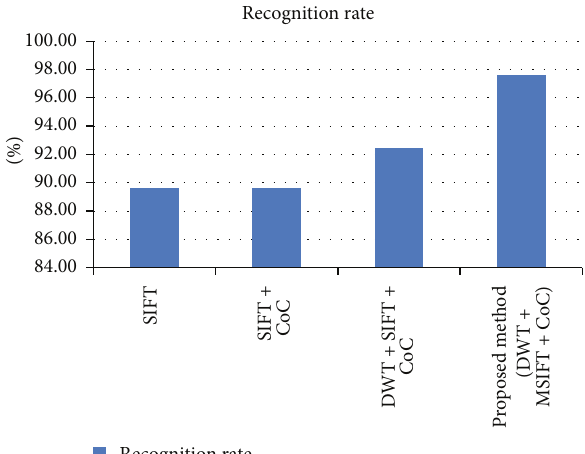
Figure 8: Image recognition rate with JAFFE